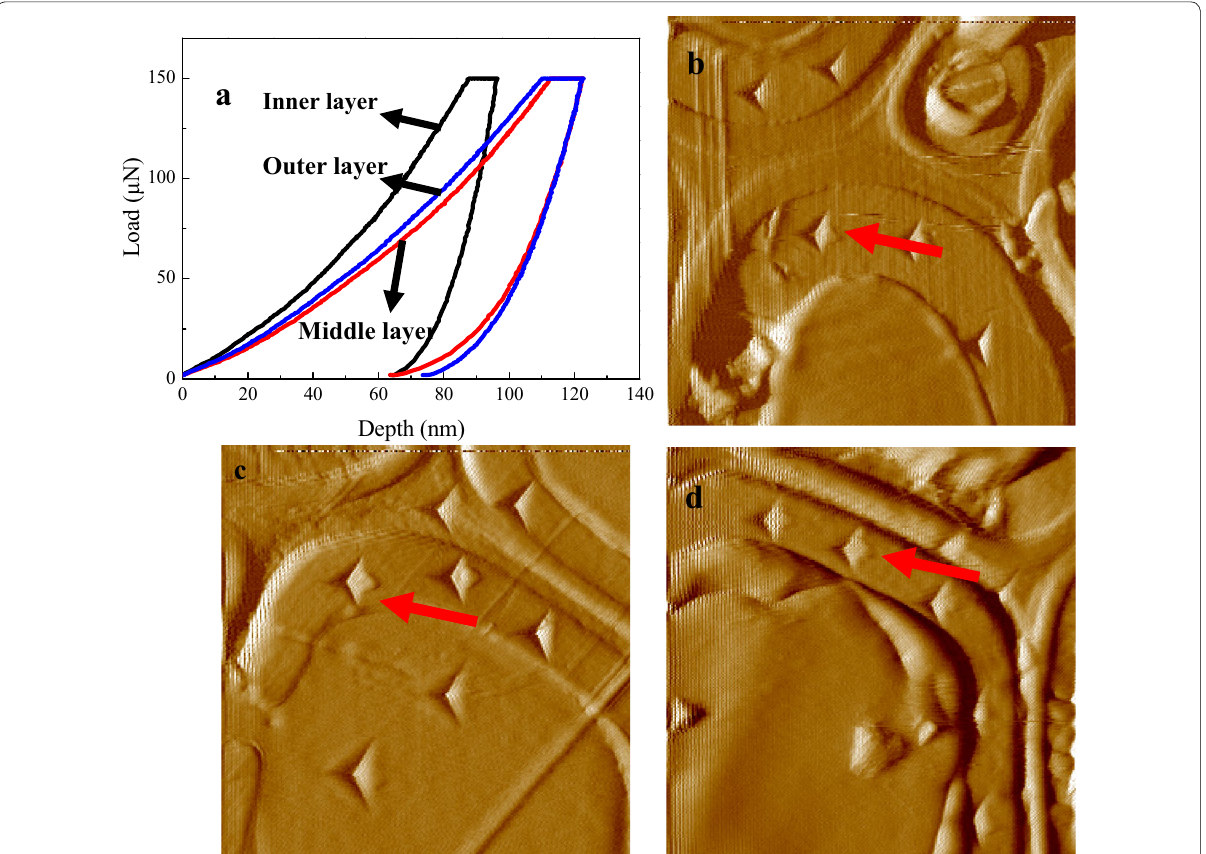
Fig. 5 a Typical load–depth curves of nanoindentation tests in cell wall of windmill palm fibers in different layers; Residual indentations on cell wall of windmill palm fibers in a inner, b middle, c outer